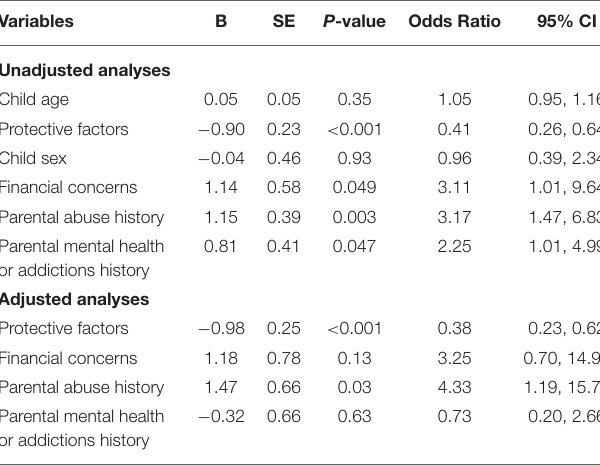
TABLE 3 | Unadjusted and adjusted logistic regression analyses of risk factors for poly-victimization status. Variables B SE P -value Odds Ratio 95% CI Unadjusted analyses